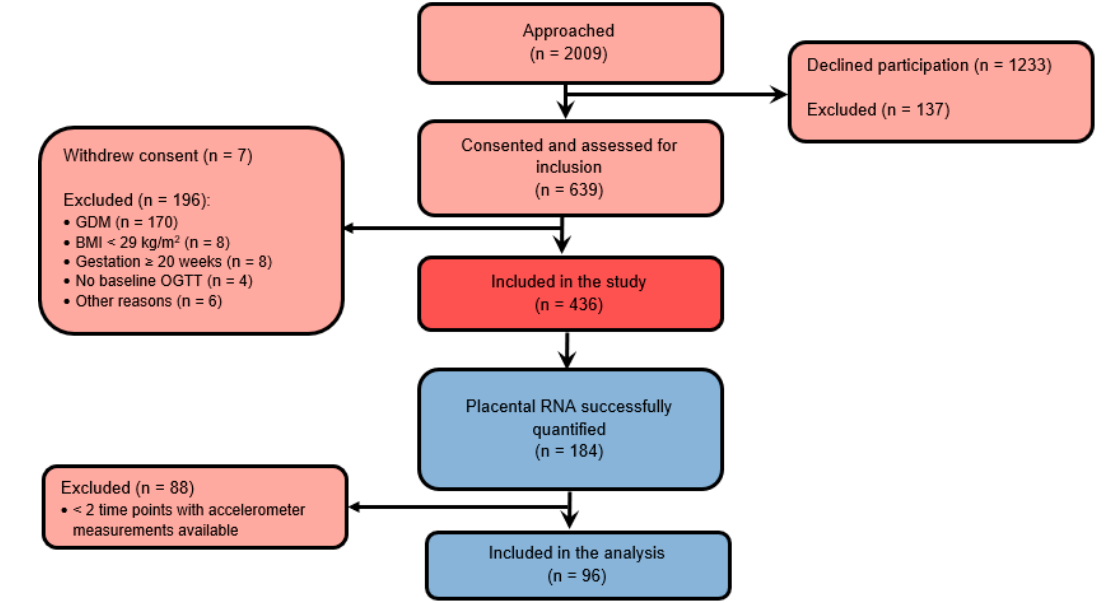
Figure 1. Flow diagram of study participants. Table 1. Characteristics of study sample comparing included and excluded participants.